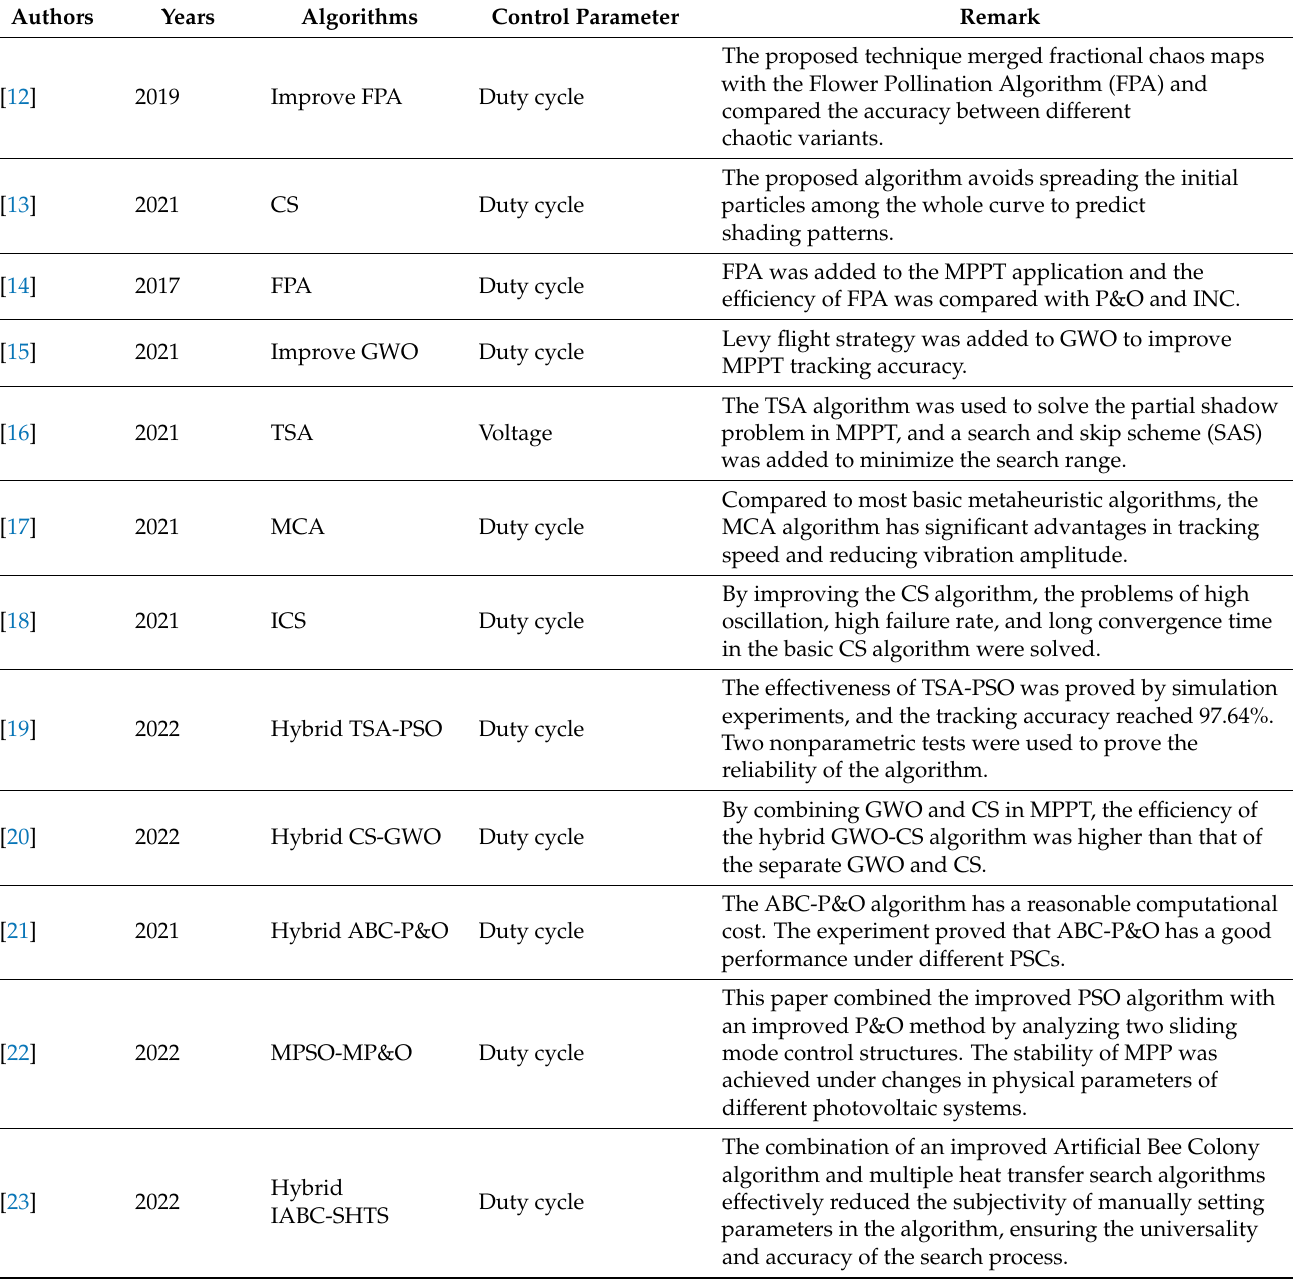
Table 1. Research summary of published MPPT